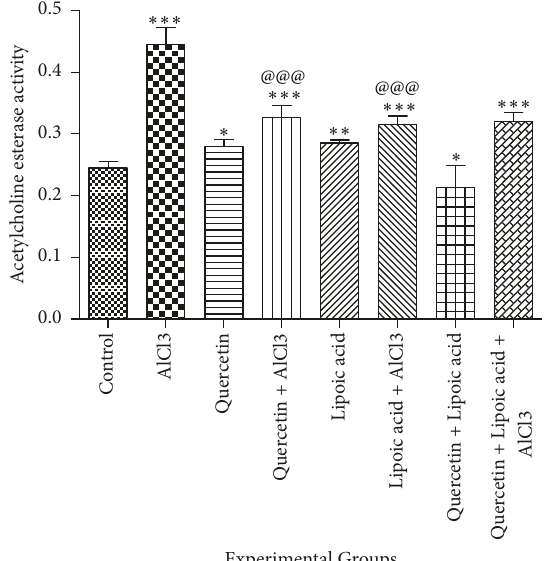
Figure 1: The effect of aluminium chloride, quercetin, and lipoic acid treatment on acetylcholine esterase activity in the brain of rats. Enzyme activity is expressed as nmoles of substrate hydrolyzed min −1 mg protein −1 in the brain of rats. ∗∗∗ Significant as compared to control group of rats ( 𝑝 < 0.001 ). ∗∗ Significant as compared to control group of rats ( 𝑝 < 0.01 ). ∗ Significant as compared to control group of rats ( 𝑝 < 0.05 ). @@@ Significant as compared to AlCl 3 treated group of rats ( 𝑝 < 0.001 ). Comparison between the groups was done using Dunnett’s multiple comparison